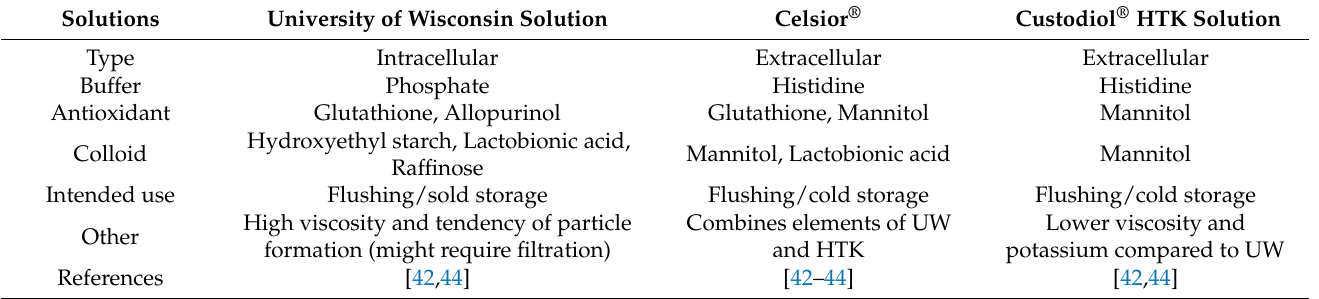
Table 1. Clinically used heart preservation